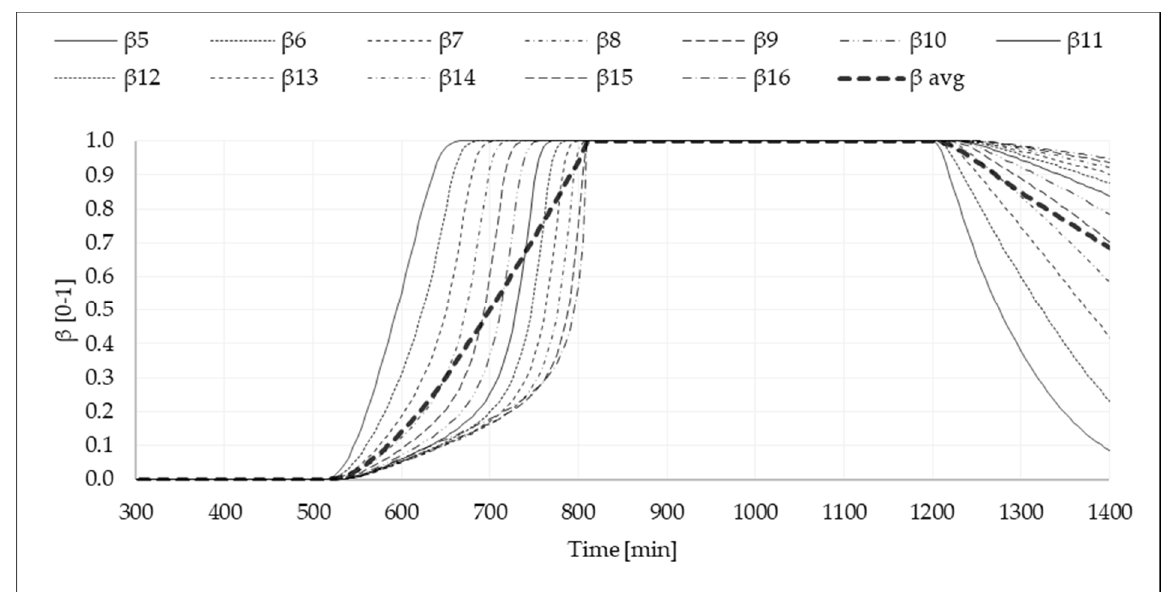
Figure 14. Stage of melting in each control volume representing PCM ( β i ), and average stage of melting for whole PCM layer ( β avg ).